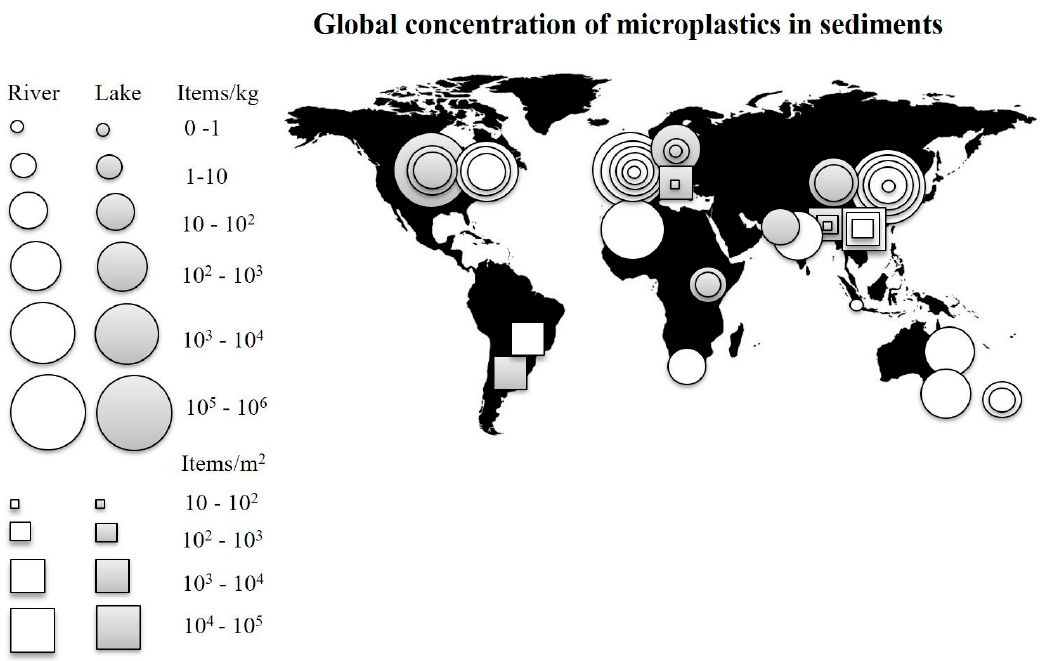
Figure 6. Global concentration of microplastics in lotic and lentic sediments (including beaches and near shore sediments) expressed in items/kg and items/m 2 : Stacked concentric circles and rectangles indicate the presence of multiple different concentration values in the same study area. The units of measurement items/m 3 and items/L are homologated in items/kg to allow the graphic presentation of a greater number of values, according to the following assumptions. In nature, the weight of 1 L of water sample depends on different sources, for instance, whether it is